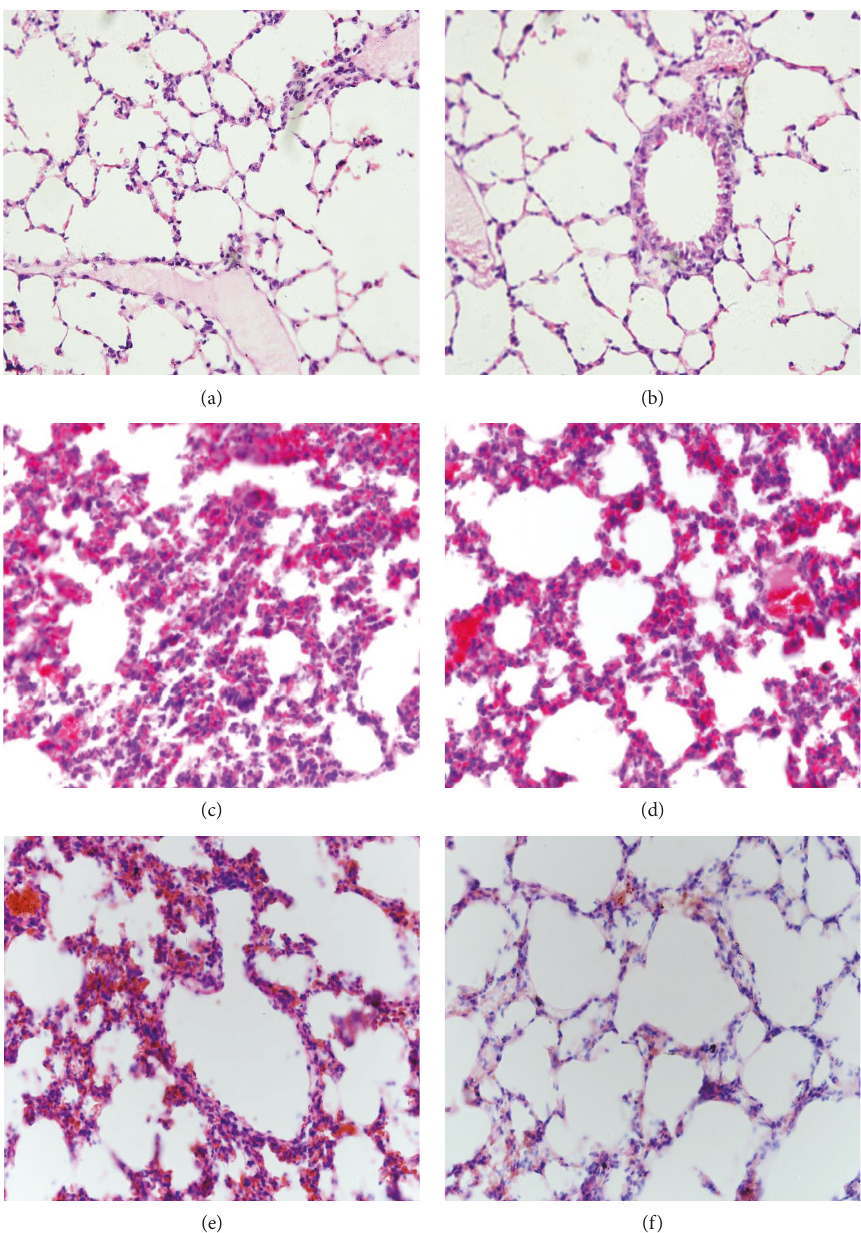
Figure 2: Representative H&E sections of pulmonary tissues (magni fi cation: 200 × ). At 24h after treatment, the elderly sham group (a) and the younger sham group (b) had no obvious in fl ammation; however, the elderly fracture group (c) and the younger fracture group (d) show typical manifestations of acute lung injury. At 72h after hip fracture, the lung in fl ammatory manifestations of younger fracture group (f) had subsided, but it was still obvious in the elderly fracture group